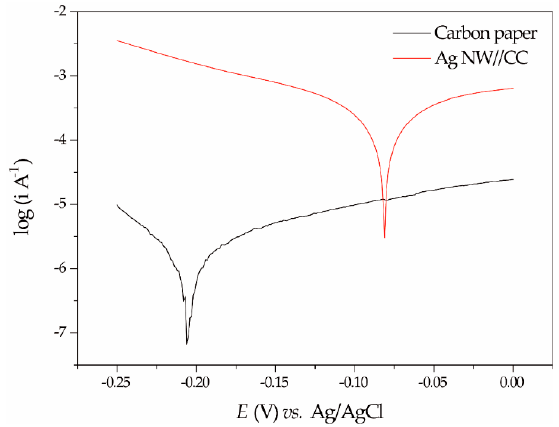
Figure 4. Tafel polarization curve of pristine CC and Ag NW//CC.